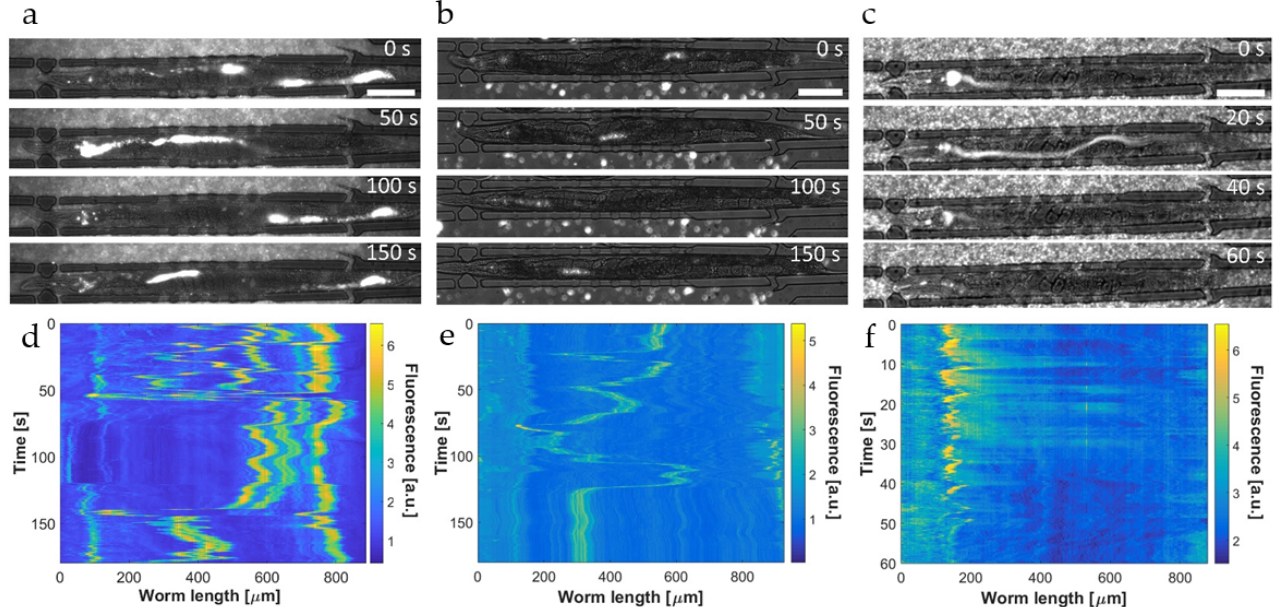
Figure 5. Analysis of the bacterial digestion and transit of indigestible microbeads in the worm intestine. ( a – c ) Representative fluorescence time-lapse low-resolution (20 × ) images of 3 YA N2 C. elegans worms immobilized in on-chip traps and fed E. coli OP50 RFP mixed with red fluorescent melamine microbeads ( a ), red fluorescent microbeads only ( b ), or E. coli OP50 RFP only ( c ), respectively. In ( b ) many beads located in the liquid chamber surrounding the worm can be seen. ( d – f ) Corresponding color plots of time-lapse recordings of the fluorescence intensity of the 3 nematodes in ( a – c ) showing the evolution and distribution of the bacterial load and/or the fluorescent beads. ( d ) Superposed diffuse and localized signals related to intact/disrupted bacteria and microbeads and ( e ) spatially constraint signal features generated only by microbeads. Microbeads are not digested in the gut and the periodic displacement of the intestinal load by peristaltic action, from the grinder to the hindgut and vice versa, can be tracked in both cases. ( f ) Fading of the fluorescent signal is observed after feeding the worm E. coli OP50 RFP only. Ingested bacteria initially accumulate in the pharynx and are subsequently pushed towards the posterior region of the gastrointestinal tract. A rapid signal decay occurs in the mid/posterior section of the intestine, starting at t > 30 s after the onset of peristalsis. This decay can be attributed to biochemical digestion, as the RFP label is not sensitive to the acidic environment in the gut. Scale bars = 100 μ m.